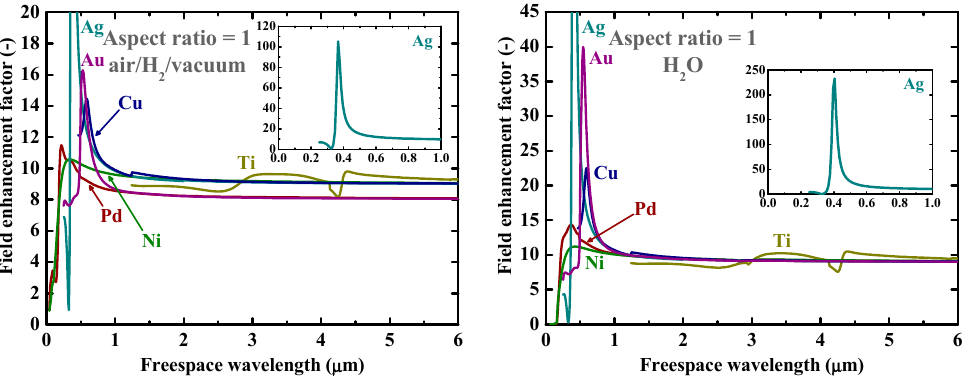
Figure 4. Calculated electromagnetic field enhancement factors at the tips of spheroidal nanoparticles of Au, Ag, Cu, Pd, Ti, and Ni with an aspect ratio of 10 in ( left ) air/H 2 /vacuum and ( right ) H 2 O. The insets are the clarified plots for Au, Ag, and Cu.